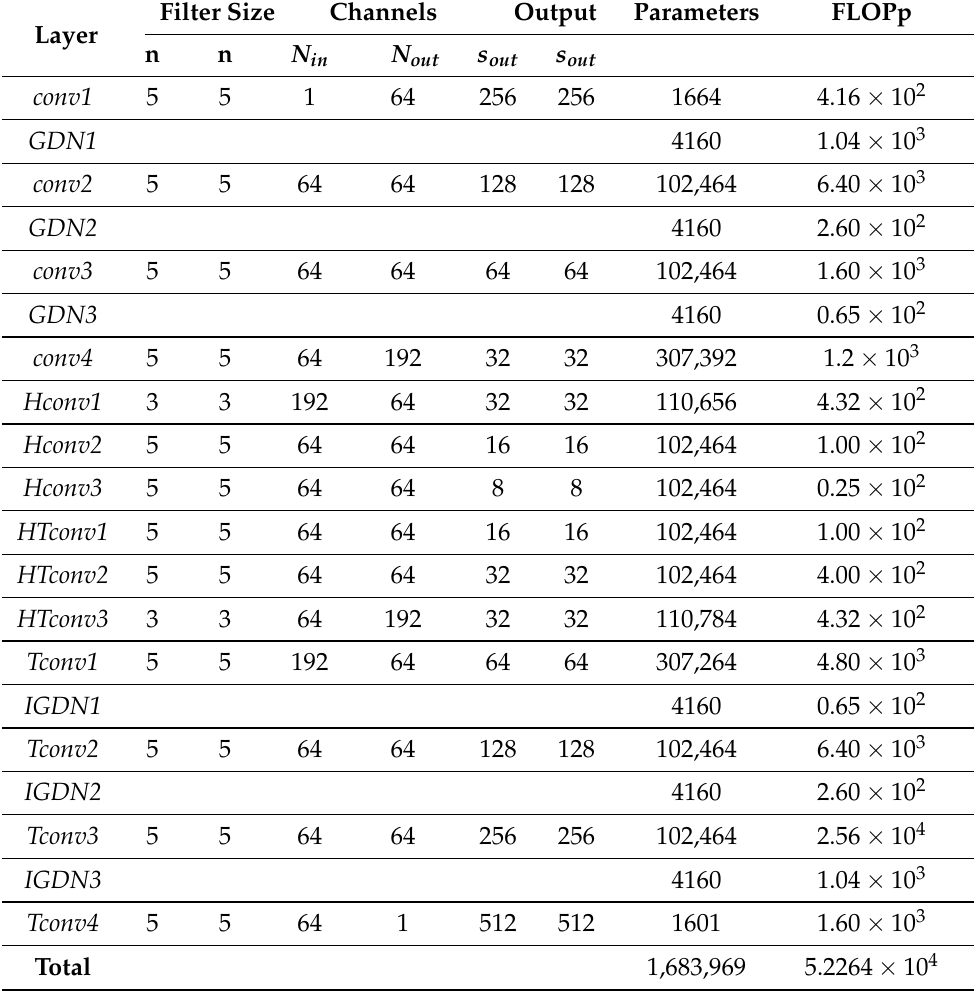
Table 1. Detailed complexity of Ballé(2018)-s-hyperprior-N64-M192.